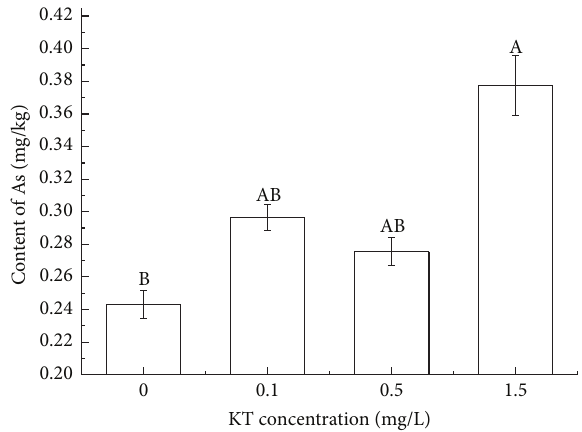
Figure 2: Effects of different concentrations of KT on arsenic uptake in maize seedlings under 0.5 mg/L arsenic stress. Values with different letters indicate a significant